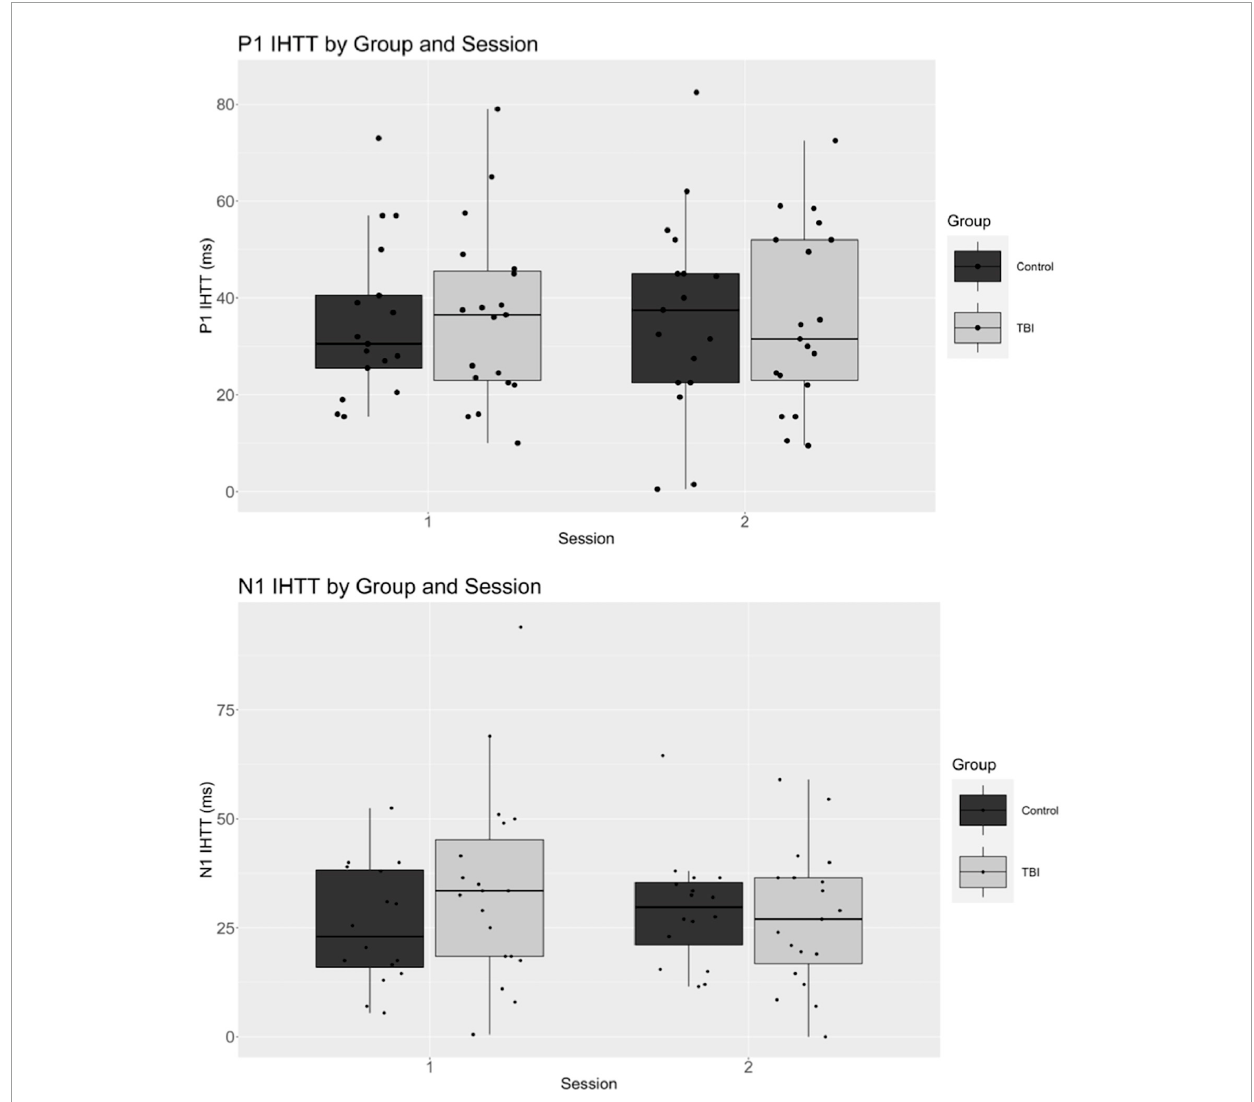
FIGURE3 Boxplots for P1 and N1 amplitude by group and